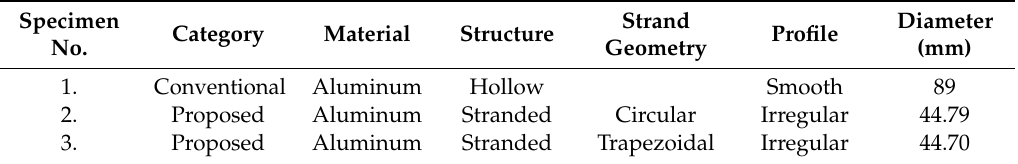
Table 2. Conductor specimens used in the comparative